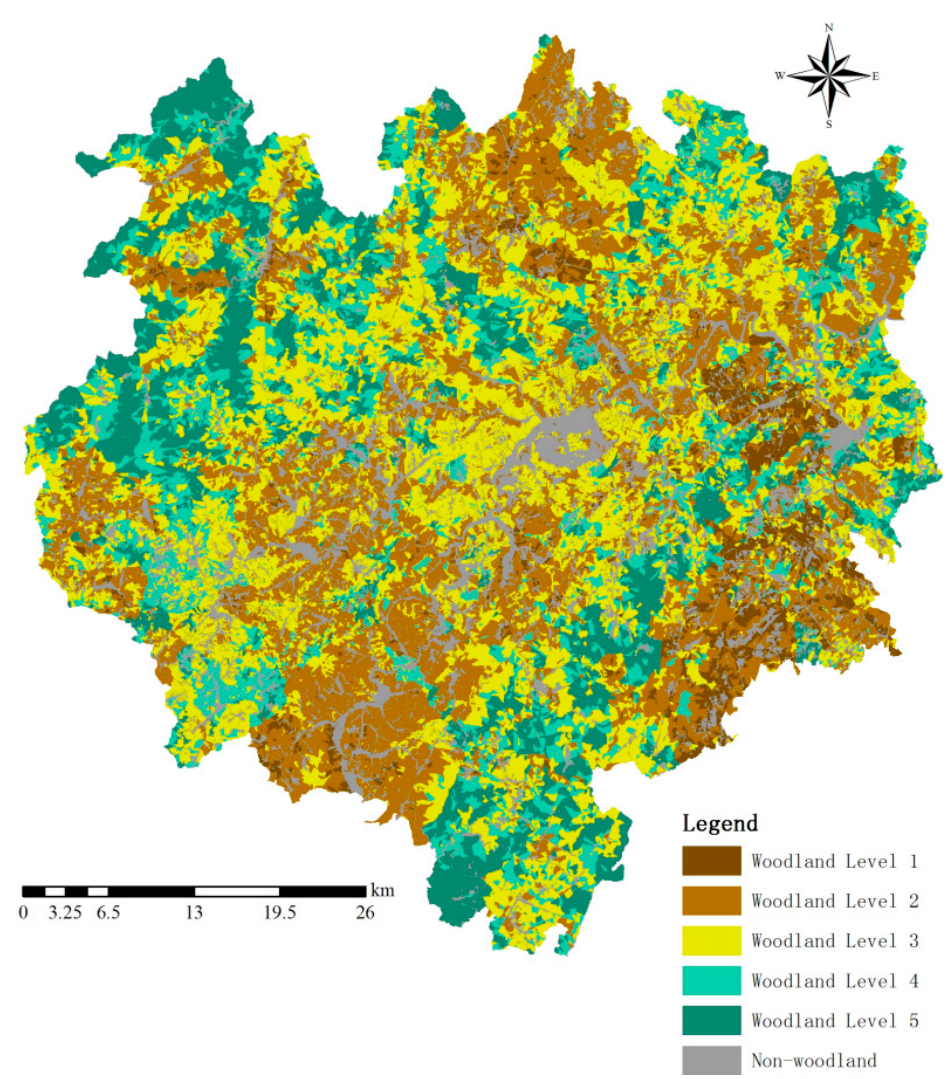
Figure 4. Forest land grade distribution map of Longquan County.